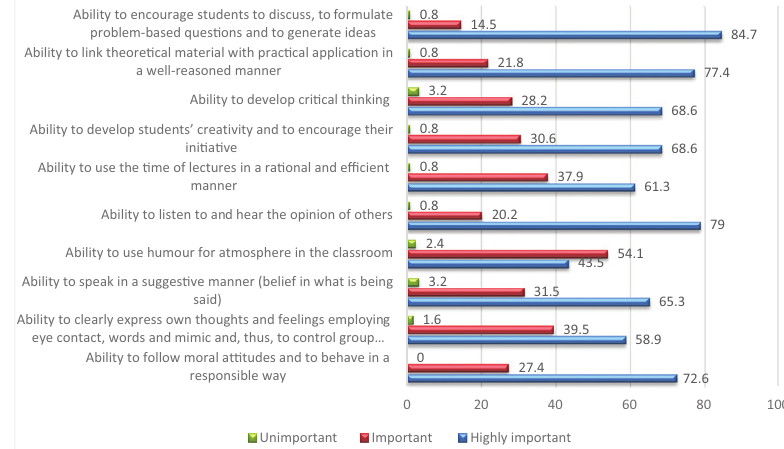
Figure 3. Abilities in the educational process according to their significance (source: created by authors)